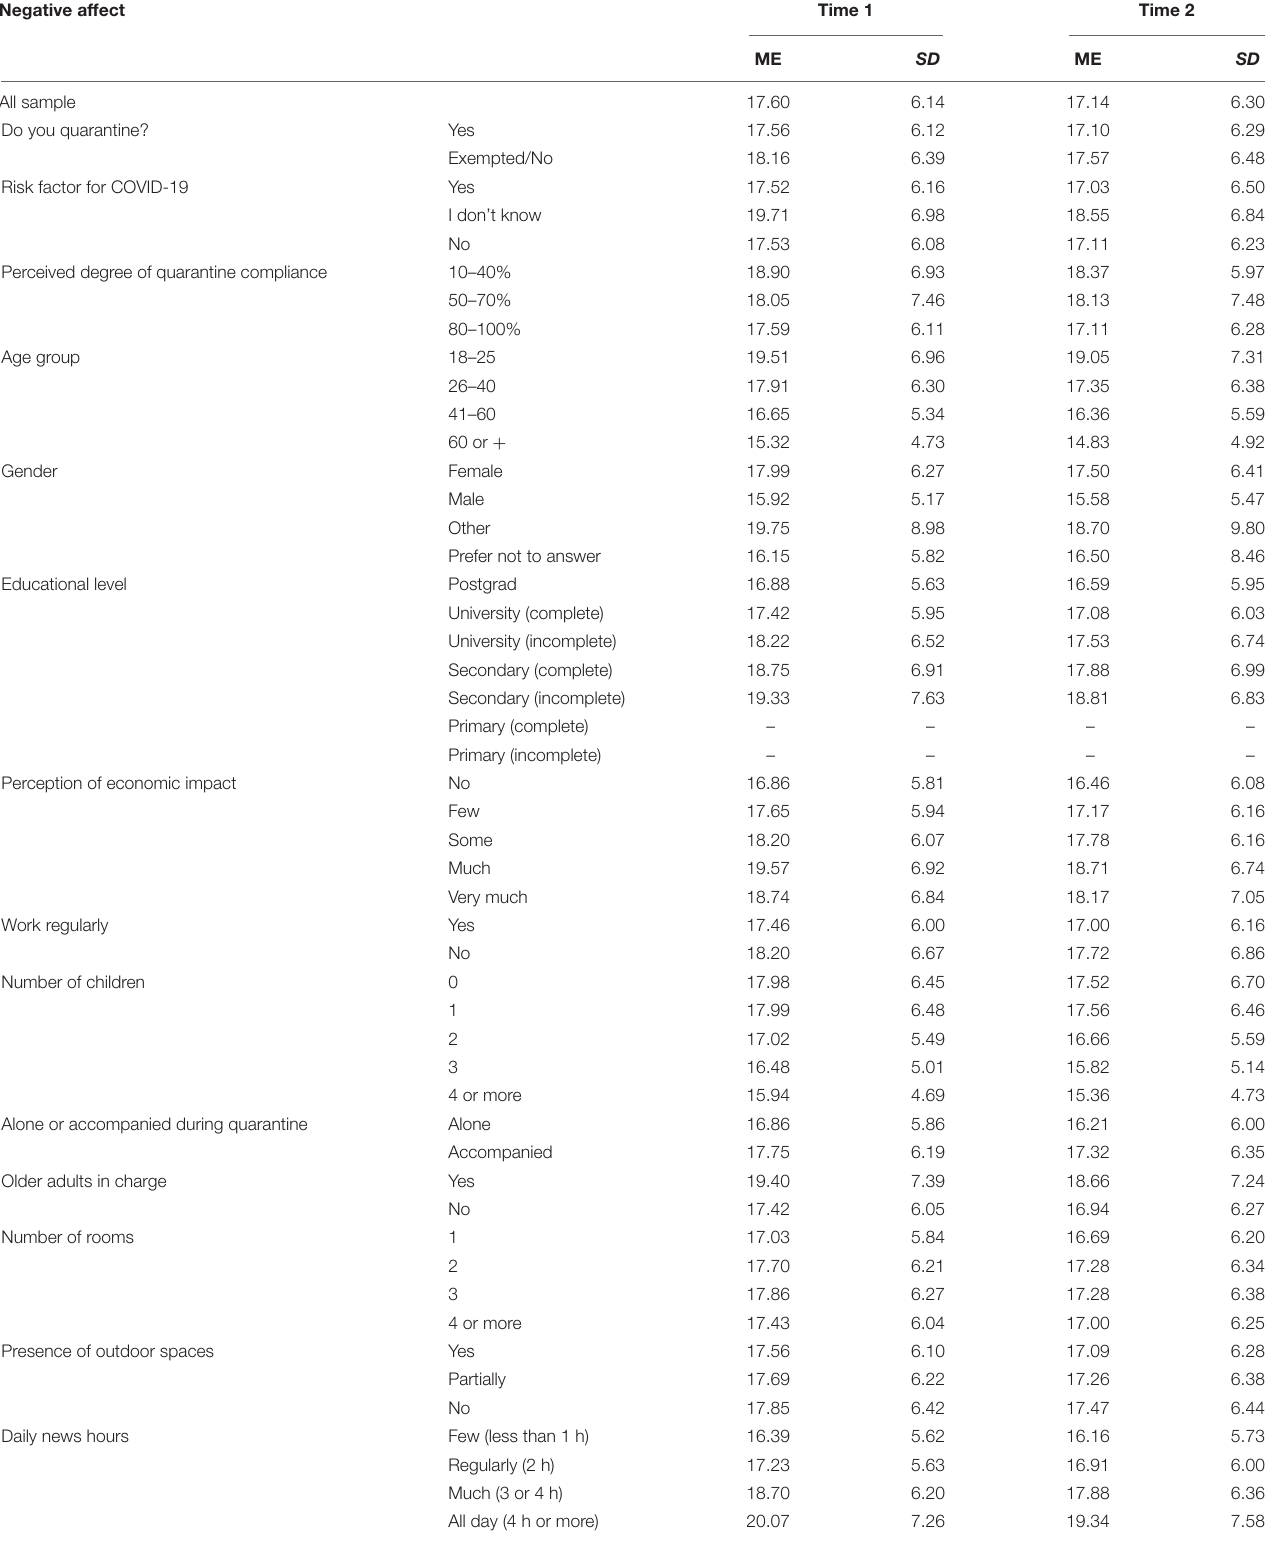
TABLE 6 | Descriptive statistics for negative affect in Time 1 and Time